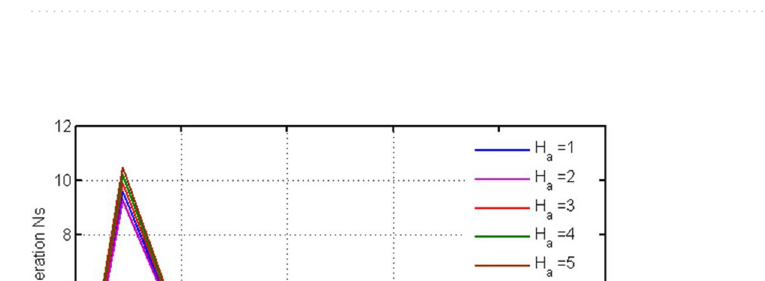
Figure 3. Plot for entropy generation versus η against Gr .